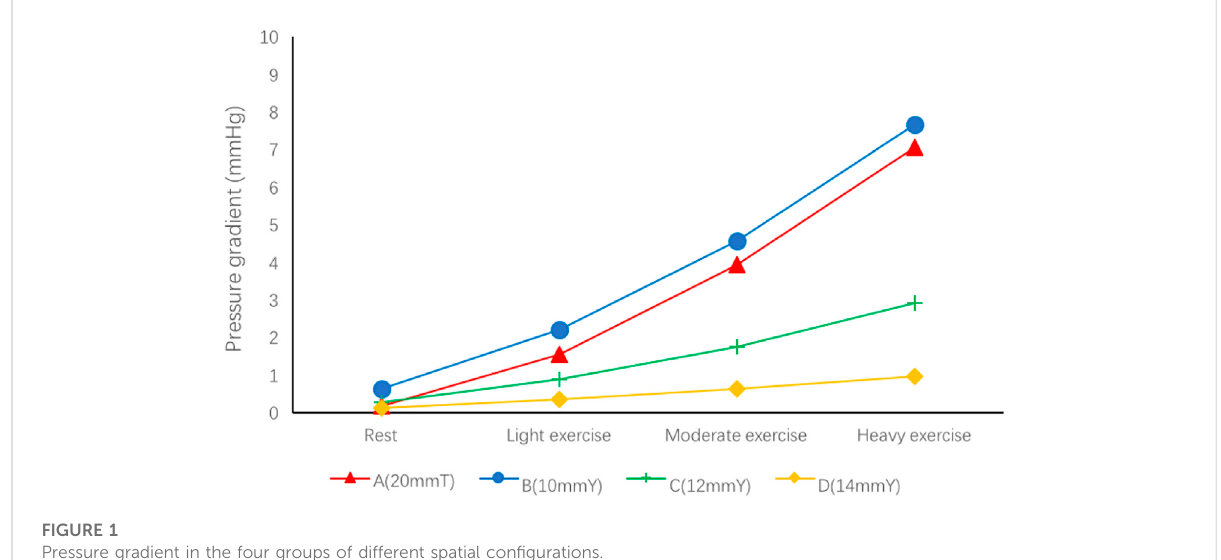
FIGURE 1 Pressure gradient in the four groups of different spatial con fi gurations.